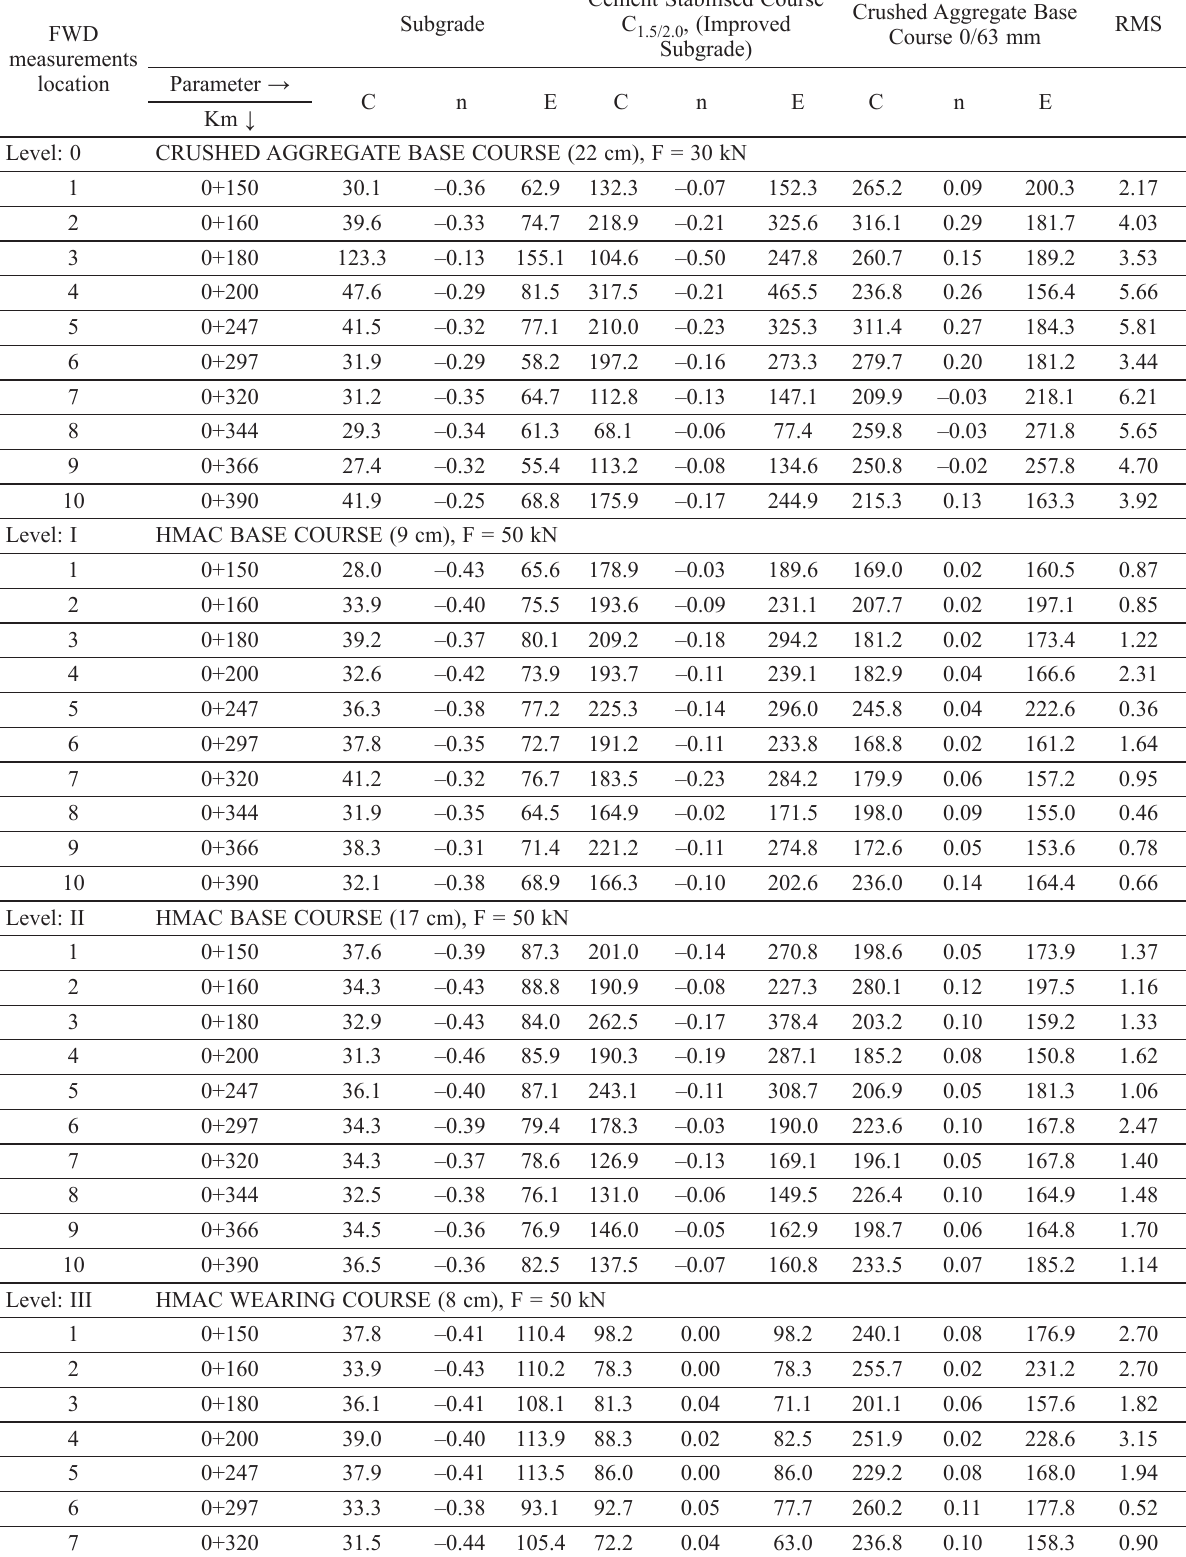
Table 1. Inverse analysis parameters identification results of selected pavement layers based on deflection basin measurements